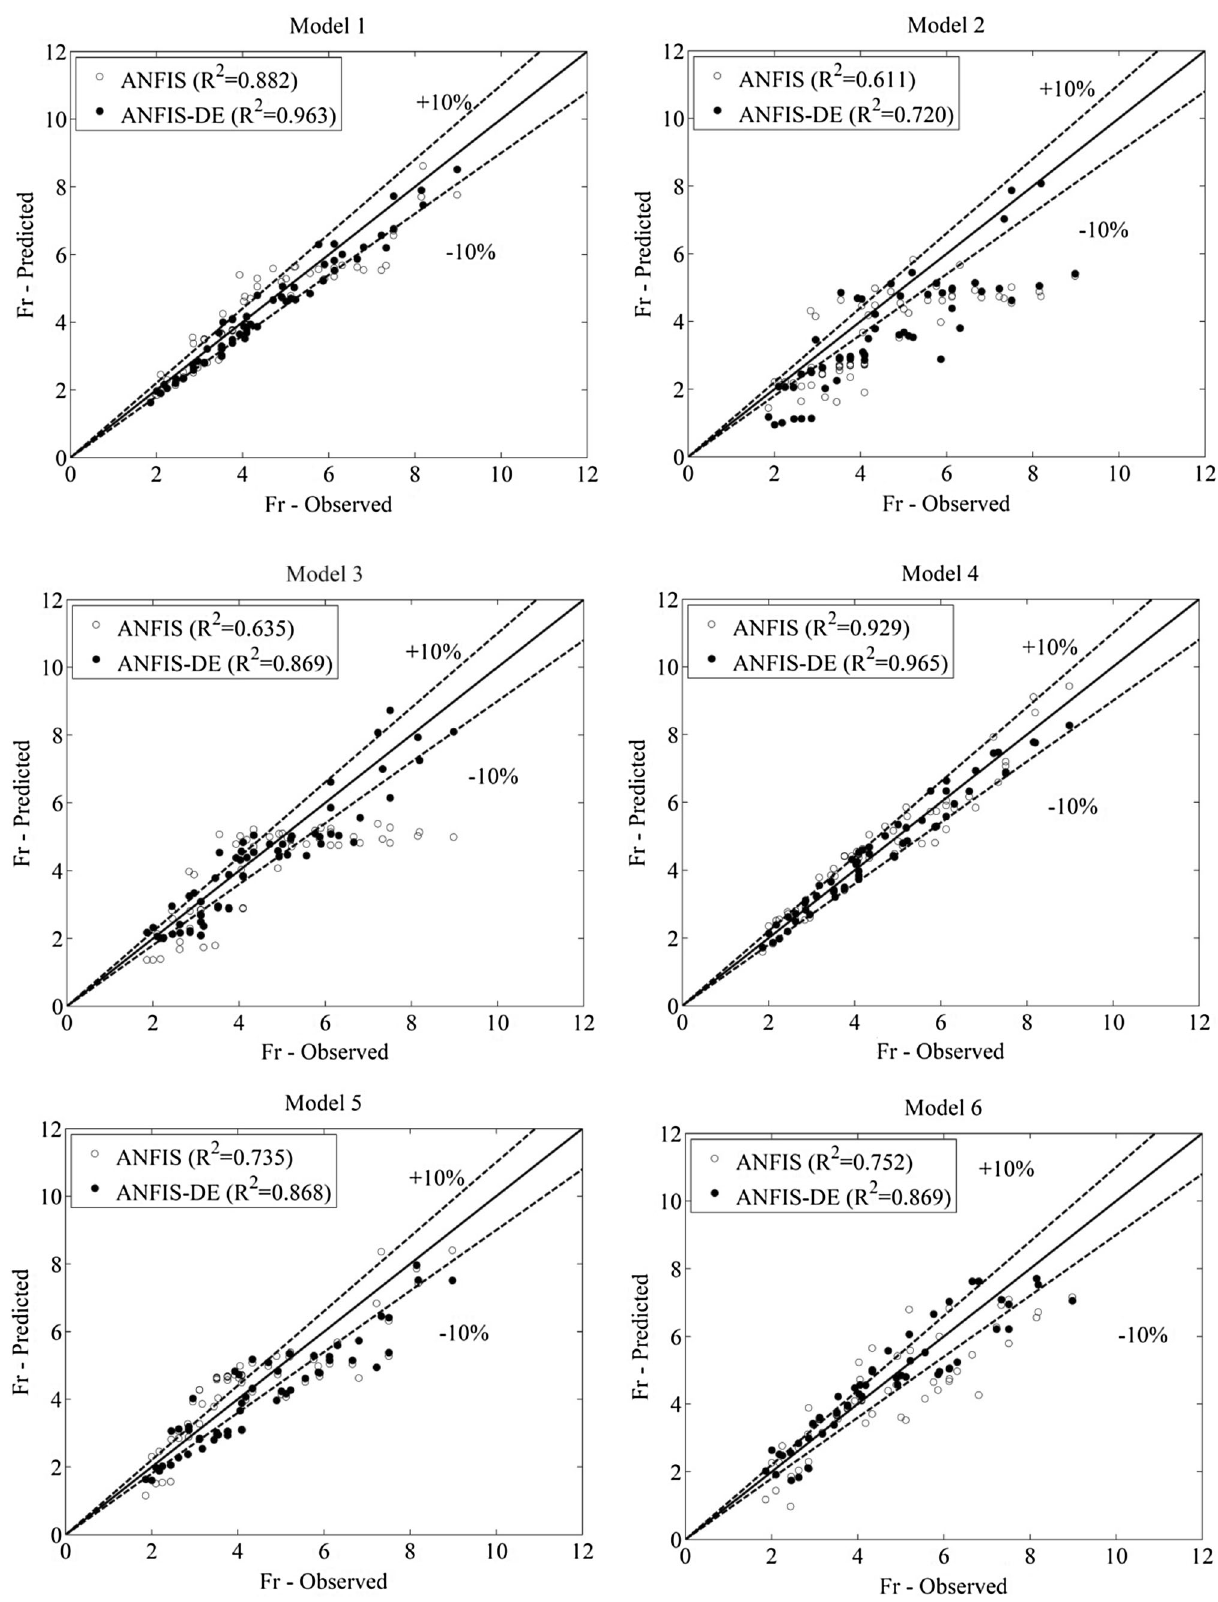
Fig. 4 Scatter plot of Fr predicted using ANFIS and ANFIS-DE